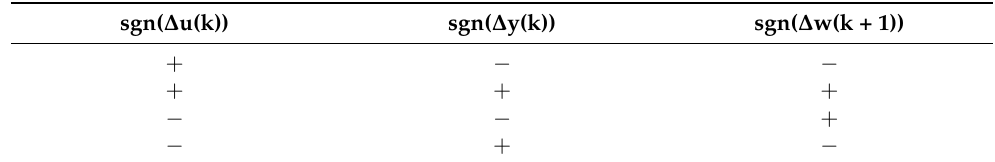
Table 1. Logic table for evaluation of ESC [67].